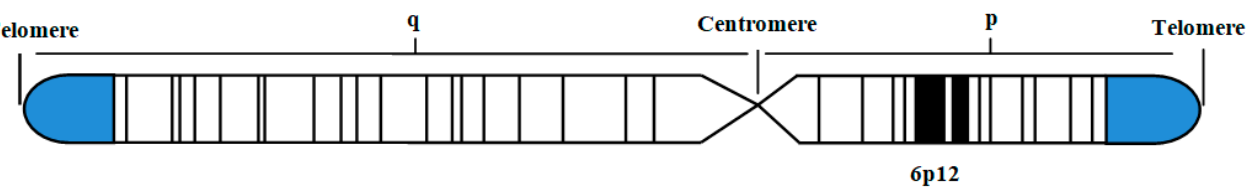
Figure 1. Location of the IL17A gene on the short arm (p) of chromosome